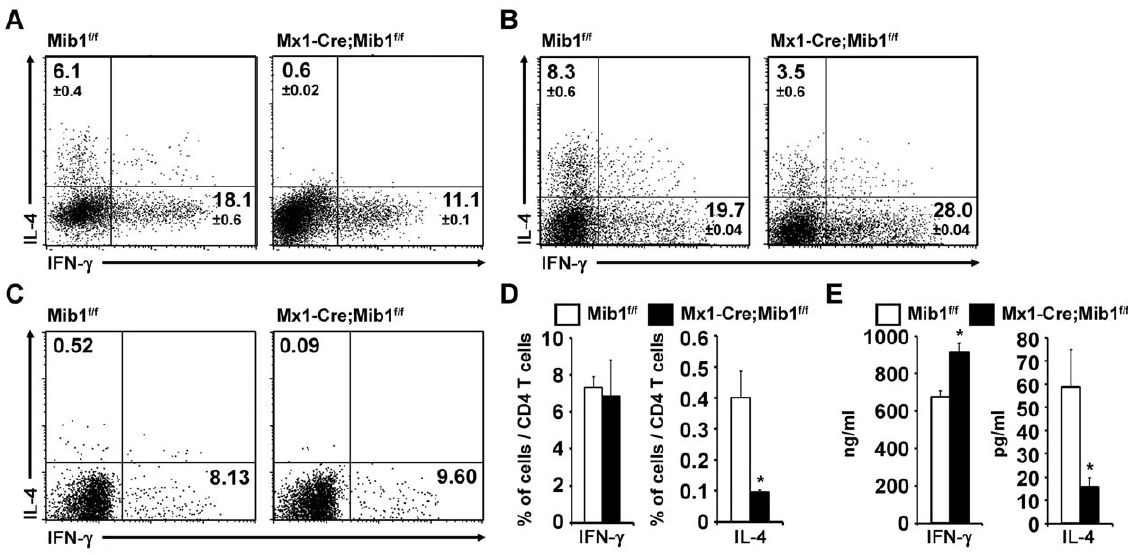
Figure 6. Mib1 in DCs is critical for Th2 induction. A , Neutralizing anti-IFN- c Abs (10 m g/ml) were treated to CD4 + T cells during the coculture with peptide pretreated Mib1 f/f or Mx1-Cre;Mib1 f/f DCs. Intracellular cytokine expression was measured by flow cytometry, as shown in Figure 5 A . The numbers indicate the mean 6 SD cell percentages from two independent experiments. B , Purified naı¨ve SMARTA CD4 + T cells were stimulated with peptide-pretreated Mib1 f/f or Mx1-Cre;Mib1 f/f DCs. Intracellular cytokine expression was measured by flow cytometry, as shown in Figure 5 A . The numbers indicate the mean 6 SD cell percentages from two independent experiments. C , Purified naive OT-II CD4 + T cells were transferred intravenously into CD45.1 recipient mice. Peptide-pretreated Mib1 f/f or Mx1-Cre;Mib1 f/f DCs were intraperitoneally injected on the subsequent day. Seven days later, splenocytes were re-stimulated for 6 h with OVA 323–339 peptides and human rIL-2, and intracellular IFN- c and IL-4 were analyzed from CD45.2 + CD4 + cells by flow cytometry. The numbers indicate the percentage of cells within the gates. A representative of three independent experiments is shown. D , The average percentage of activated IFN- c and IL-4-producing CD45.2 + CD4 + T cells (as shown in [ C ]) from three independent experiments. E , IFN- c and IL-4 productions were detected by ELISA 72 h after re-stimulation. *, P ,